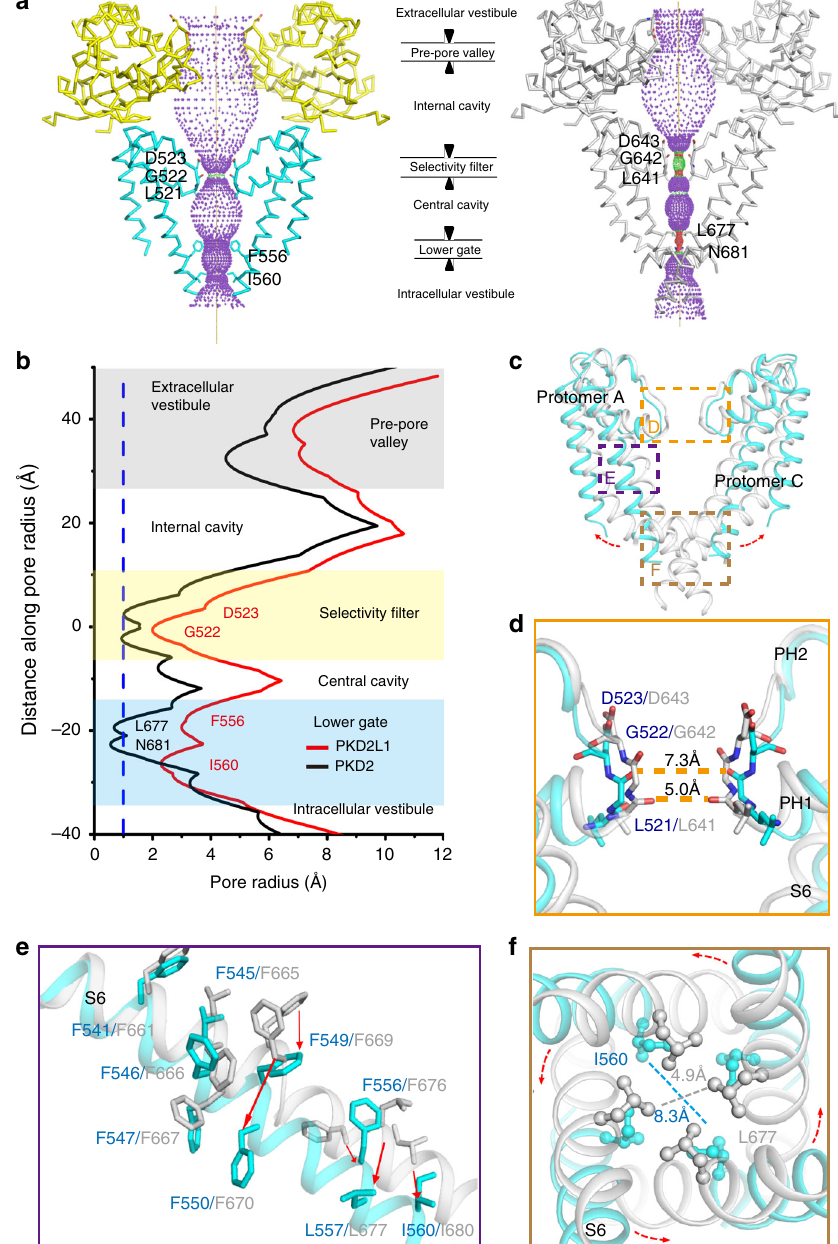
Fig. 2 PKD2L1 pore suggests its open conformation in comparison with PKD2 structure. Throughout the analysis, PKD2L1 structures are colored in cyan, green, or yellow according to different domains, and PKD2 or closed-state PKD2L1 model are colored in gray. a The channel passage of PKD2L1 (left) or PKD2 (right, 5T4D) is indicated by purple dots in the center of two diagonal protomers (pore region from chain A and C, polycystin domain from chain B and D) in each channel (with radius smaller than 1.15 Å colored red, between 1.15 and 2.3 Å colored green). The position of selectivity fi lter is set as the origin of the y -axis. b Pore radii of PKD2L1 (red) and PKD2 (black; 5T4D) along the ion-conducting pathway calculated by HOLE program. c Superimposed examinations between the pore domains of PKD2L1 and PKD2 (only two S5-PH-S6 of diagonal protomers are shown). d Comparison of the selective fi lter/ upper gate between PKD2L1 and PKD2. To emphasize the difference, the two structures of PKD2L1 (cyan) and PKD2 (gray) were superimposed relative to pore helices PH1 and PH2. The constriction site at the upper gate is G522 (PKD2L1) or L641 (PKD2), respectively. Corresponding to PKD2L1 residues, the residue names and numbers in PKD2 are shown in gray immediately after the slash, throughout this study when applicable (In the case of closed-state PKD2L1 model, the respective residue names and numbers in PKD2 are shown in gray within parentheses). e S6 segments of PKD2L1 and PKD2 adopt different conformations. A high-energy π -helix can be witnessed in PKD2 while PKD2L1 only gets a normal α -helix. The absence of this π -helix in PKD2L1 accompanies the C-terminal part of S6 to bend away from the permeation pathway and to shift one residue towards the cytosol. Red arrows emphasize the discrepancies with respect to side chains of marked residues. f Comparison of the lower gate between PKD2L1 and PKD2. Two structures were superimposed similarly as in c . The constriction site at the lower gate is I560 (PKD2L1) or L677 (PKD2), respectively. The counterclockwise red arrows emphasize the comparative differences from PKD2 to